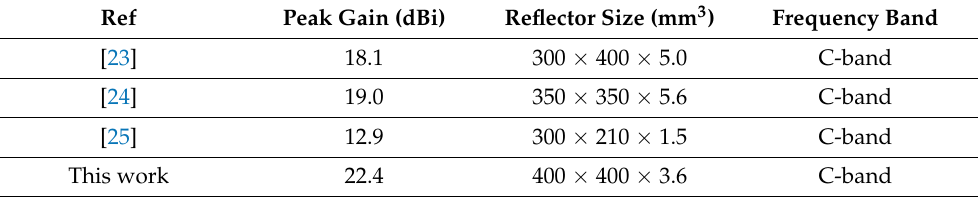
Table 3. Performance